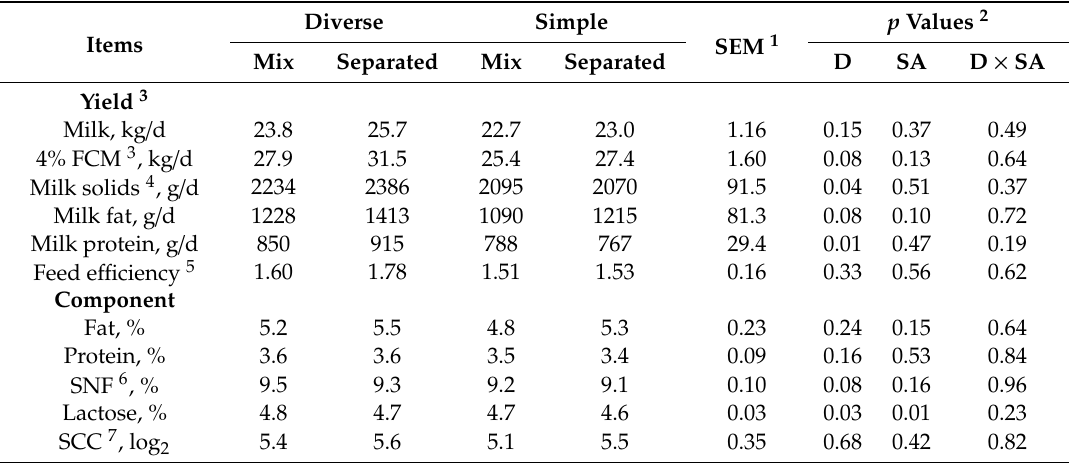
Table 5. E ff ect of pasture diversity (diverse or simple) and spatial arrangement (mix or separated) on milk yield and